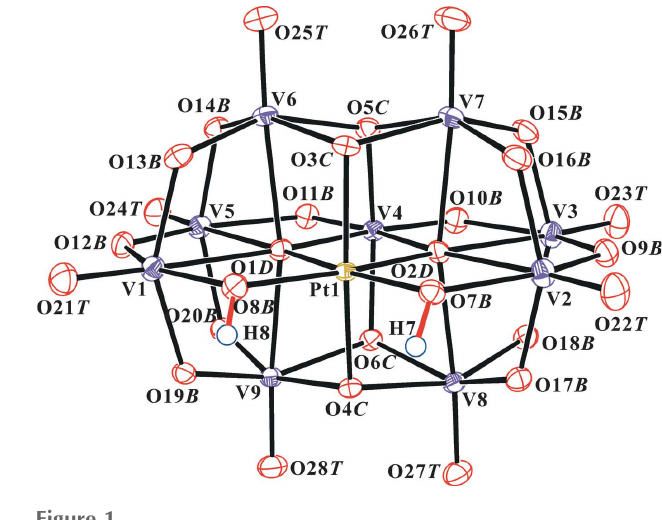
Figure 1 The molecular structure of the heteropolyanion in the title compound showing the atom-numbering scheme. Displacement ellipsoids are drawn at the 50% probability level. H atoms are presented as small spheres of arbitrary